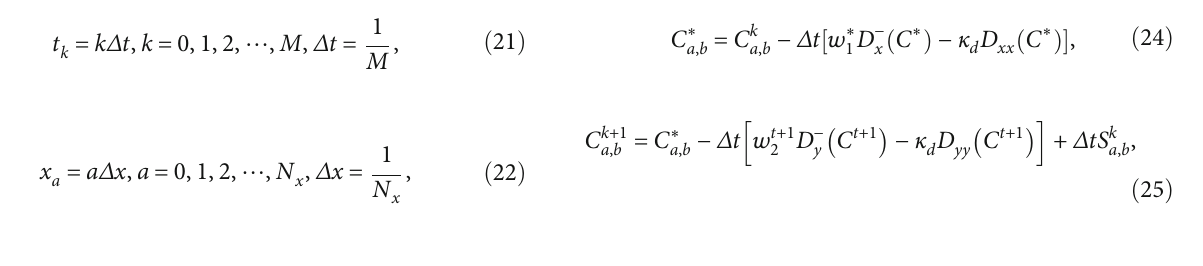
Figure 4: Movements of 300 pedestrians during smoke spreading, where the source is in the middle of the room. The velocity fi eld ð w the advection-di ff usion equation (13) is chosen randomly out of the interval